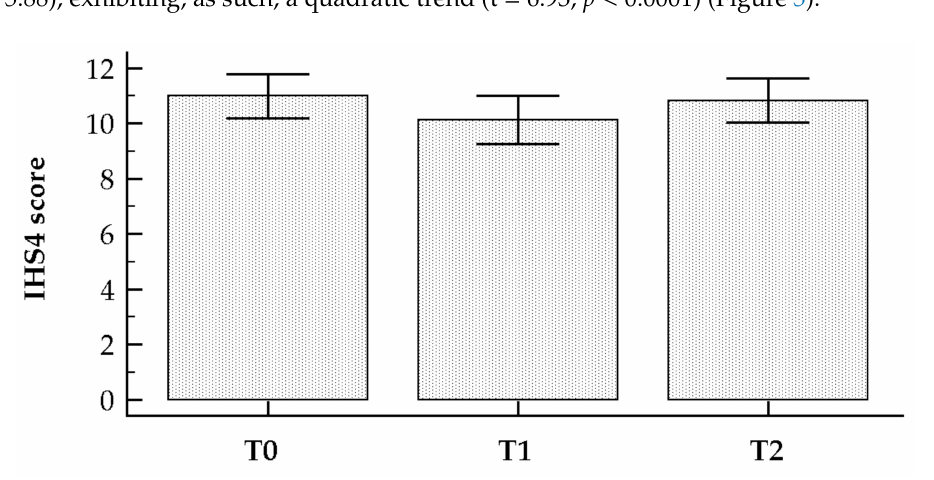
Figure 5. Change in the IHS4 score at the di ff erent time-points (T 0 before the beginning of the month of Ramadan, T 1 after the end of the Ramadan fasting, and T 2 one month after the fasting